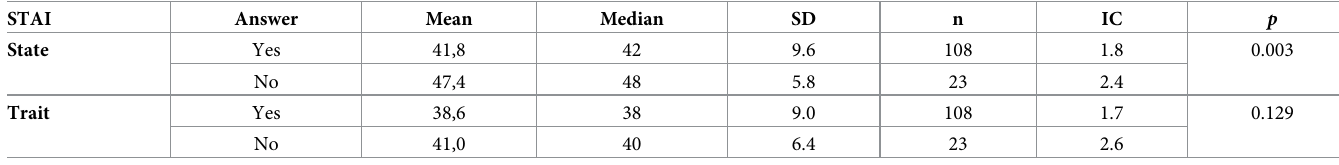
Table 4. Comparison between anxiety levels (assessed by STAI) proactivity. STAI Answer Mean Median SD p State Trait No STAI, State -Trait Anxiety